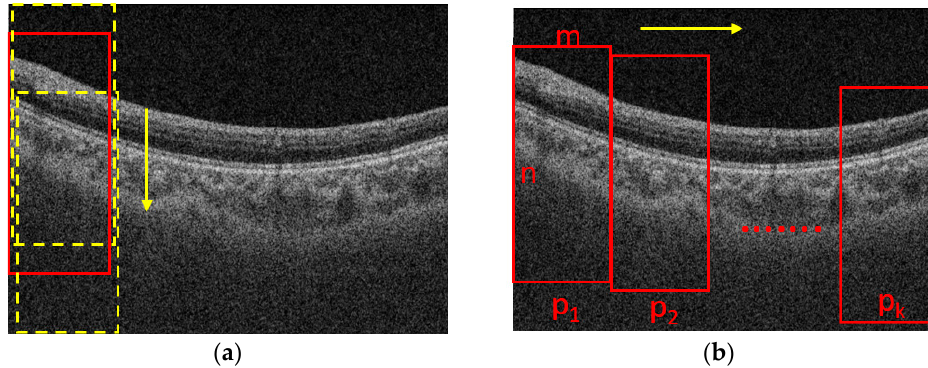
Figure 2. The process for cropping images. ( a ) sliding in the vertical direction; ( b ) sliding in the horizontal direction. m and n are the width and height of a patch p respectively.